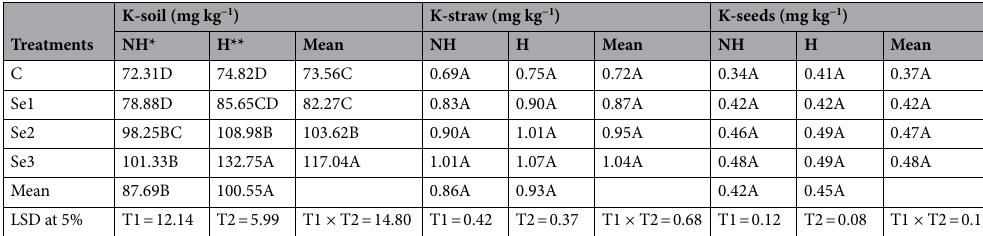
Table 4. Effect of selenium and K-humate on potassium content. *Refers to Se application without K-humate. **Refers to the simultaneous application of Se and K-humate.